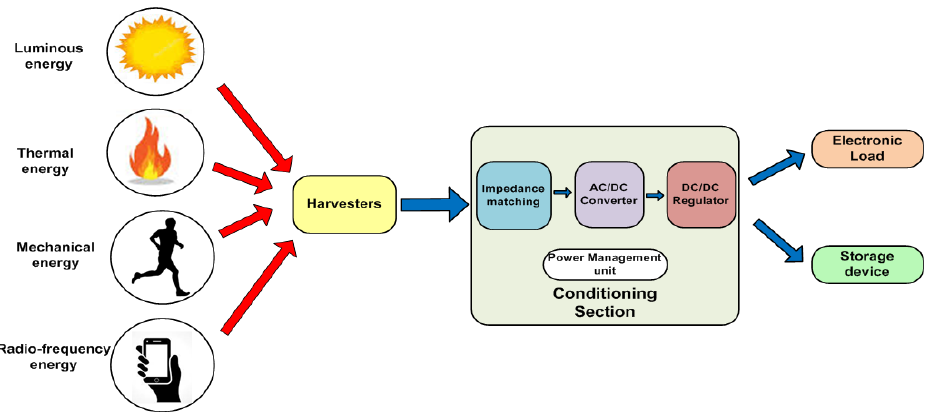
Figure 1. Block diagram of a generic energy harvesting system.